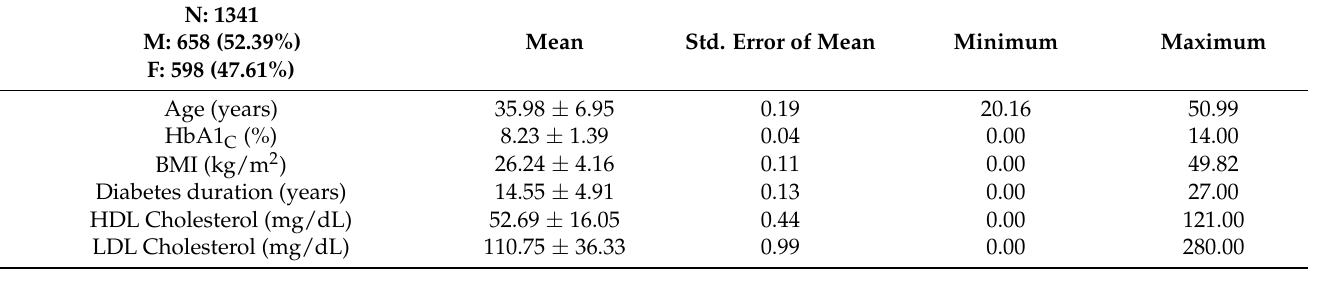
Table 1. EDIC patient baseline characteristics.